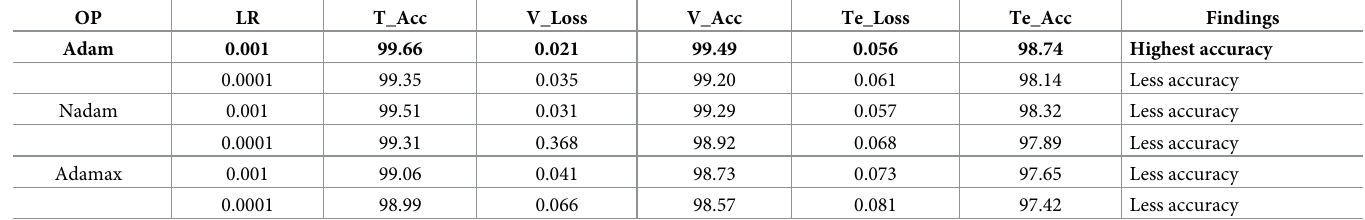
Table 12. Training loss(T_loss), training accuracy (T_acc), validation loss (V_loss), validation accuracy (V_acc), test loss (Te_loss), test accuracy (Te_acc) for each of the optimizers corresponding to the learning rates. OP LR